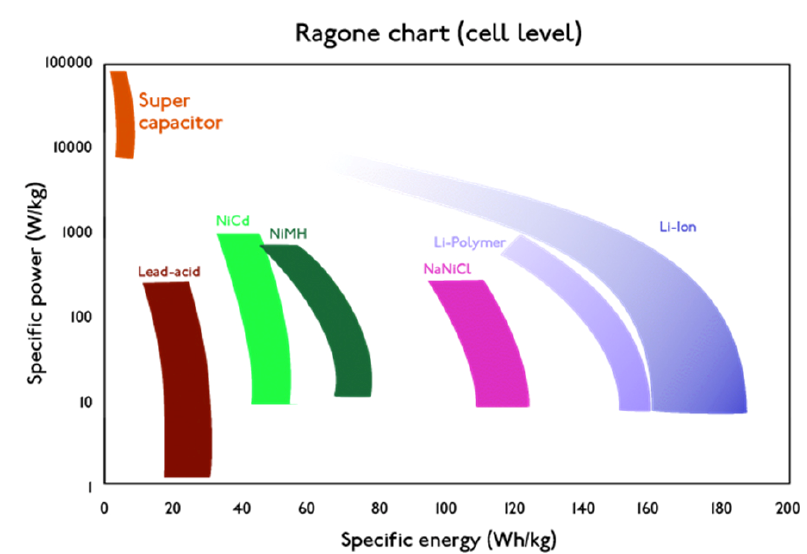
Figure 1. Rangone plot [ 3 ]